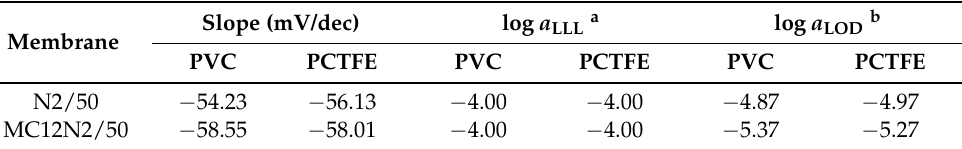
Table 2. Averages of the response characteristics determined from potentiometric calibrations of sensors with either the best-performing ion-selective membrane or its corresponding control membrane. All linear regressions had an R 2 0.999. The number of measurements and the number ≥ of sensors were n = 2 and k = 2, respectively, unless noted otherwise. See Tables A5 and A6 for averages and standard deviations, respectively, for all membranes. See Table 1 for membrane